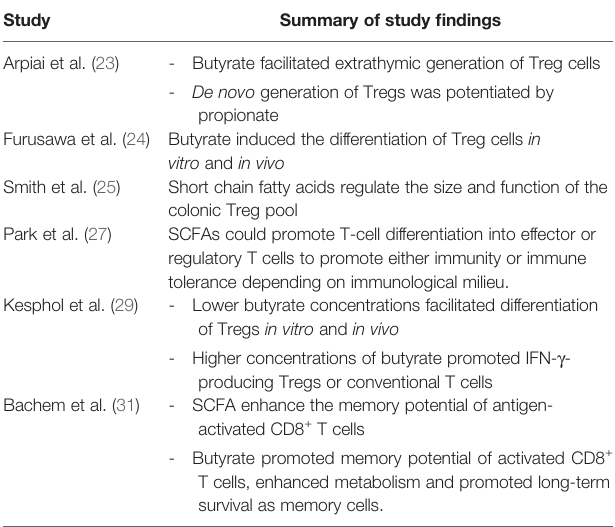
TABLE 1 | Summary of studies implicating short chain fatty acids as modulators of T cell differentiation and function.